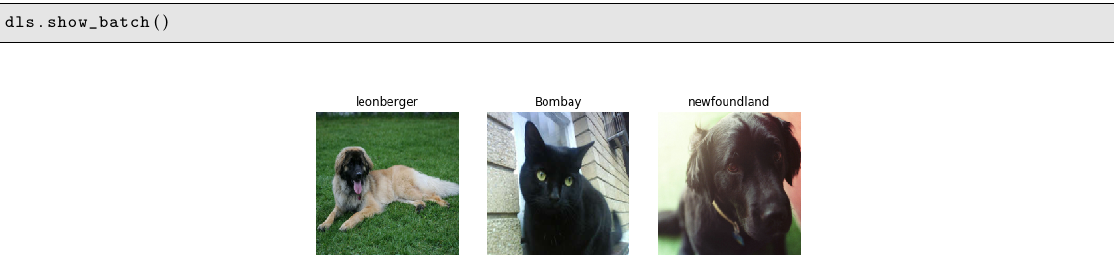
Figure 2. A DataLoaders object built with the fastai library knows how to show its elements in a meaningful way. Here the result on the Oxford IIT Pets image classification